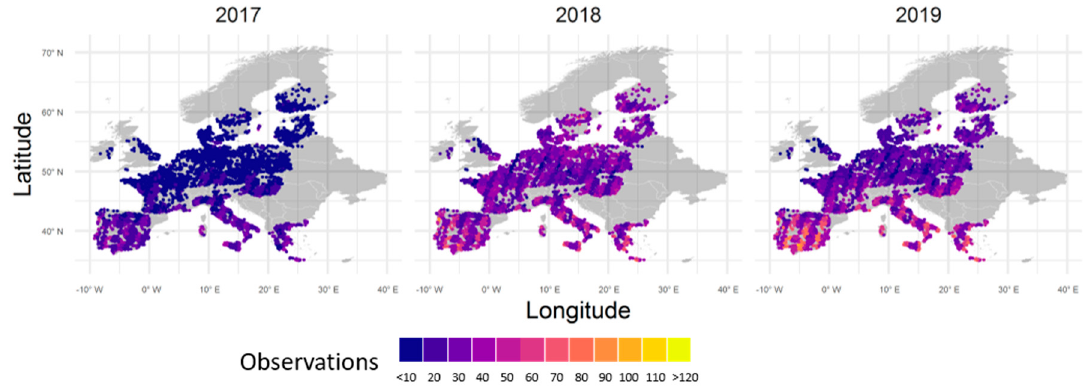
Figure 6. The annual spatial distributions of all Sentinel-2 observations .